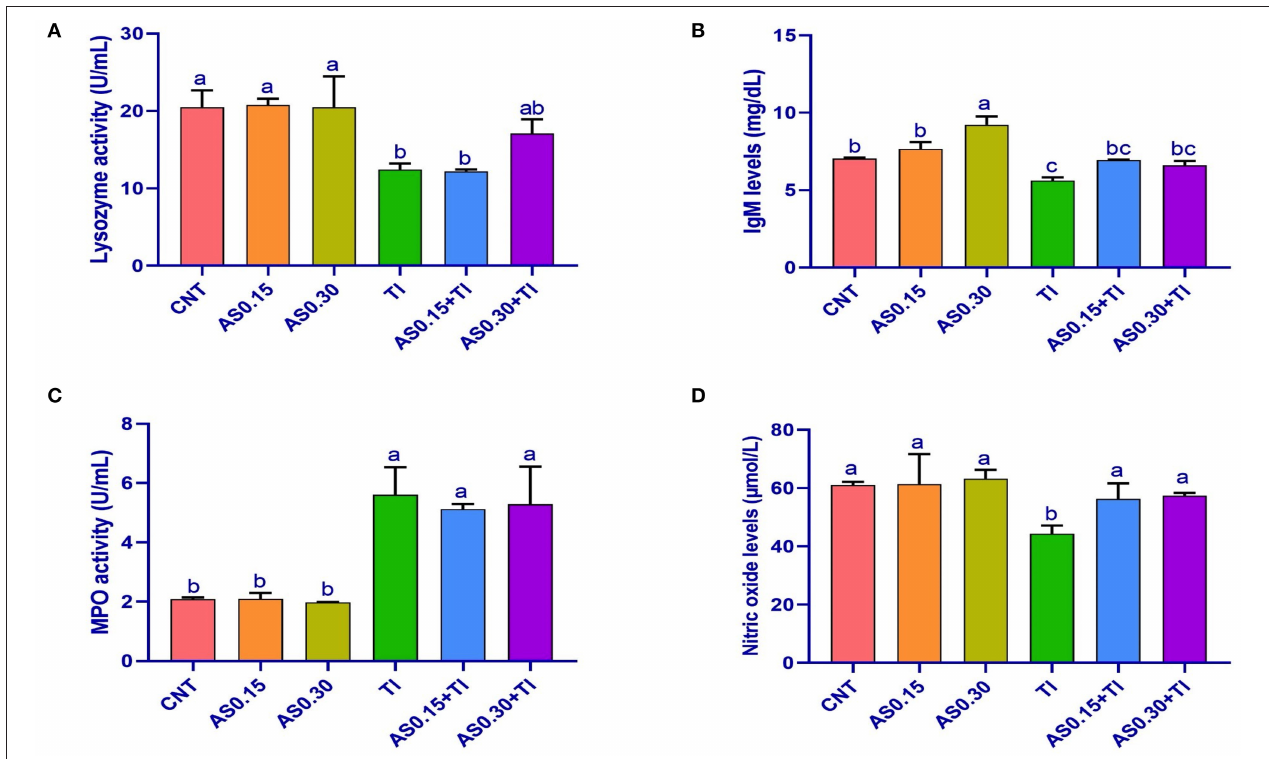
FIGURE 1 | Serum lysozyme activity (A) , immunoglobulin M (IgM) levels (B) , myeloperoxidase activity (C) , and nitric oxide levels (D) in Nile tilapia fed diets supplemented with Astragalus membranaceus polysaccharides (AS) levels (0.15 and 0.30%) and/or exposed to sublethal thallium (Tl) toxicity [1/10th lethal concentration 50 (LC50); 41.9 µ g/l] for 8 weeks. Values are mean ± SE and bars not sharing a common superscript letter (a, b, c, and d) differ significantly at P < 0.05.